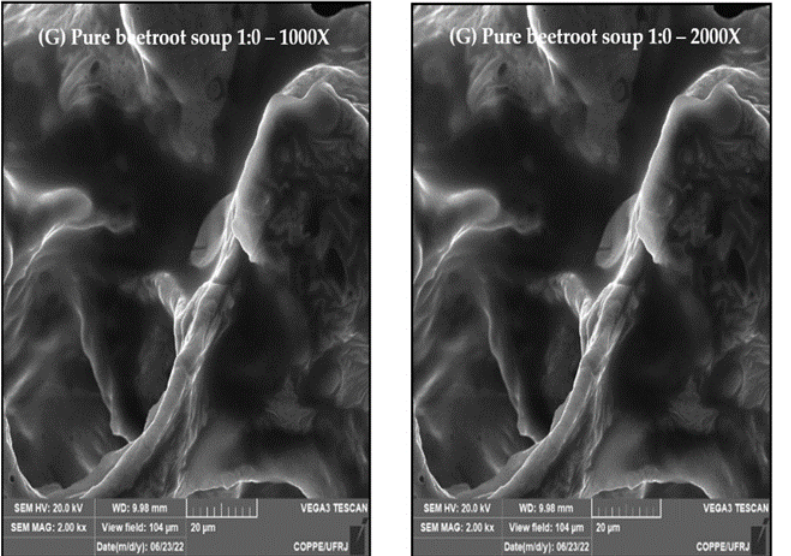
Figure 1. Beetroot soup microparticle micrographs following lyophilization in different encapsulating agents, 1000× and 4000× magnifications, respectively. ( A – C ) beetroot soup microencapsulated in starch at 1:1, 1:2 or 1:3 ( w / w ) ratios, respectively; ( D – F ) beetroot soup microencapsulated in maltodextrin at 1:1, 1:2 or 1:3 ( w / w ) ratios, respectively; ( G ) pure beetroot soup.